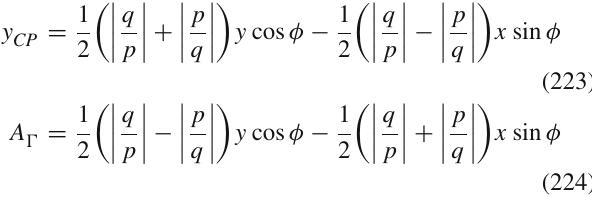
the observables measured and the fitted parameters. (cid:17) t (cid:18) is the